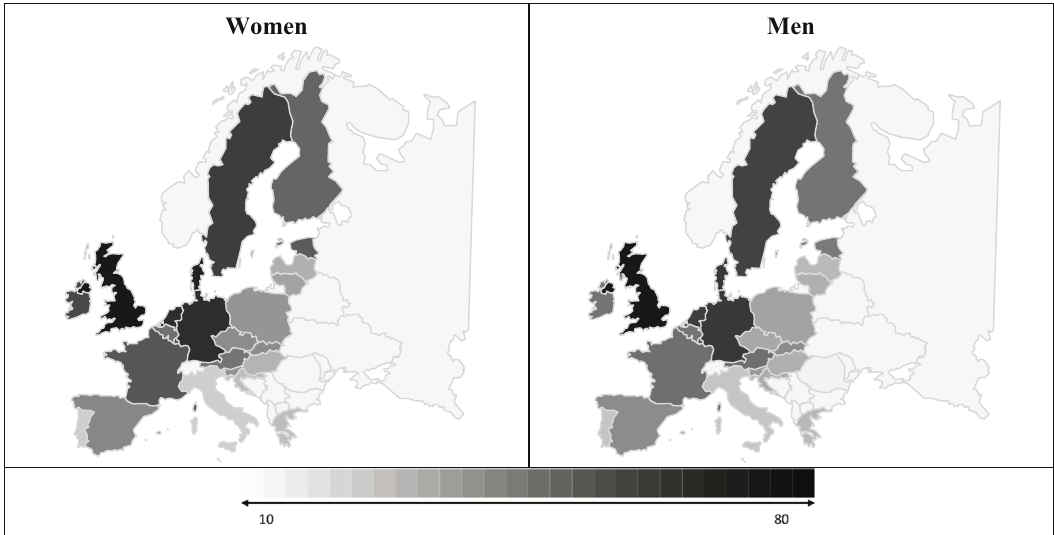
Figure 3: ICT - PURCHASE indicator in the EU - 28, 2019 ( % ) . Note: Cyprus has the same color than Croatia ’ s women and Italy ’ s men. Source: Own elaboration based on the Digital Economy & Society Database ( Eurostat ) and using Clearly and Simply ( https://www.clearlyandsimply. com/clearly_and_simply/2009/06/choropleth - maps - with - excel.html ) .